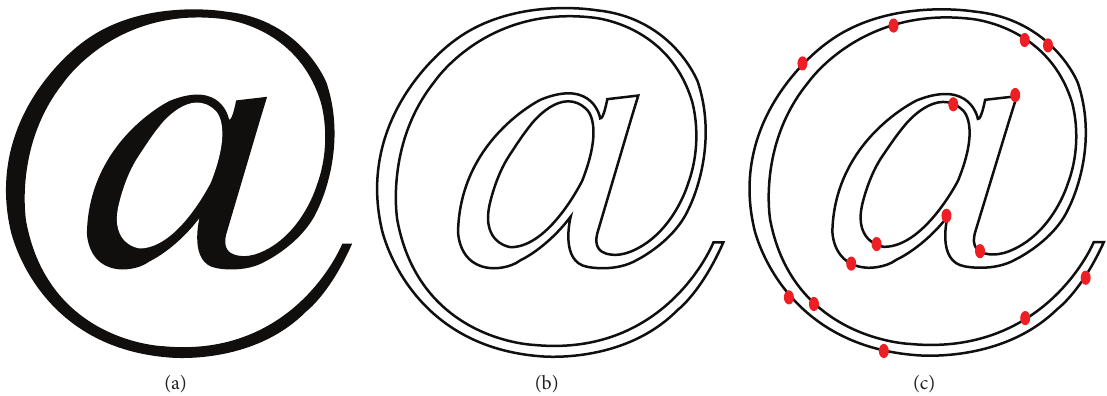
Figure 2: Preprocessing steps: (a) original image, (b) outline of the image, and (c) corner points achieved.